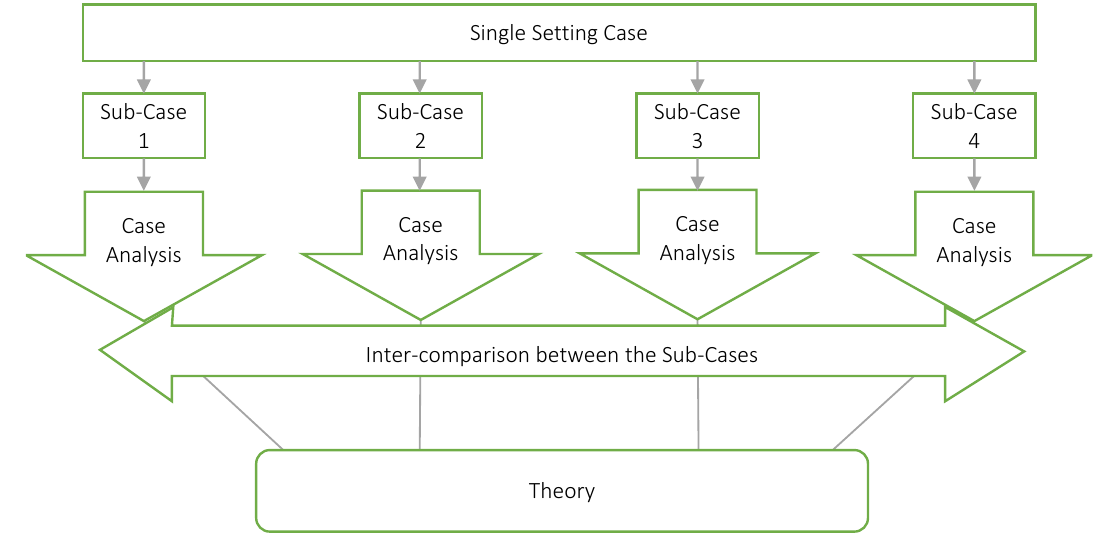
Figure 2. Single setting case and multiple sub-cases studies